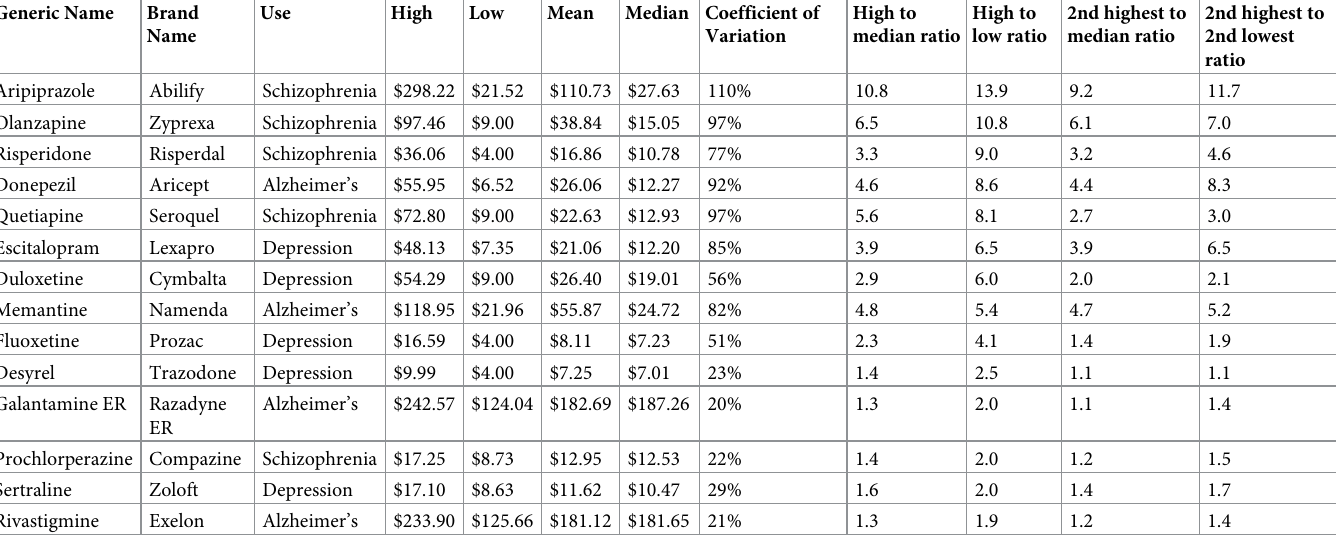
Table 1. Price dispersion parameters for neuropsychiatric medications, ordered by high to low price